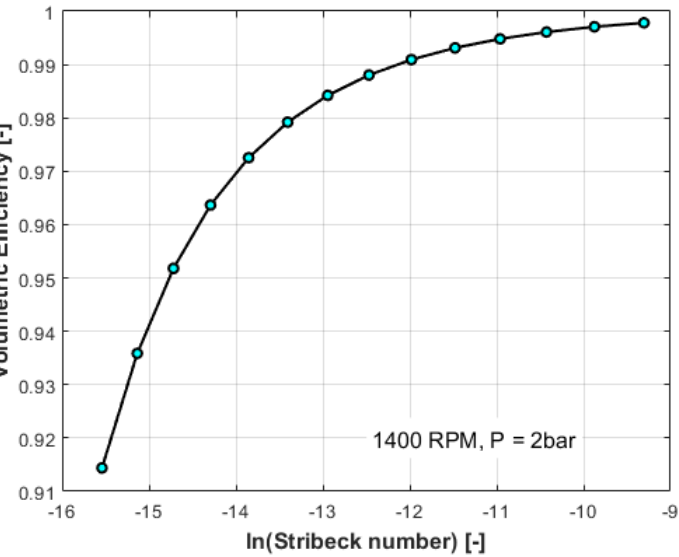
Figure 11. Volumetric efficiency of the oil gear pump for a given pump speed and pressure for different oil temperatures (20 – 150 °C).